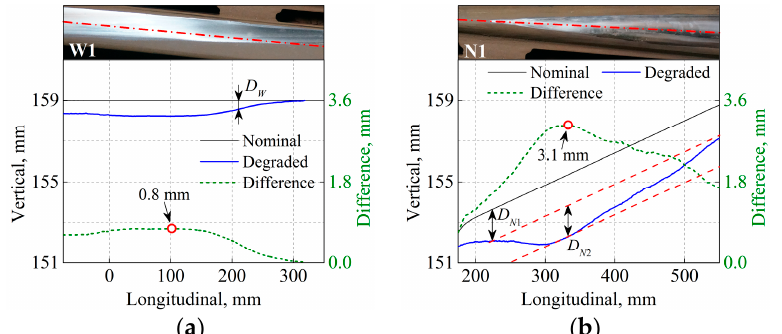
Figure 7. Measured crossing profile along cross sections W1 and N1. ( a ) Wing rail and ( b ) crossing nose. The dot ( ○ ) indicates the maximum difference in height between the nominal and degraded states. D W denotes the difference in the height of the wing rail, while D N 1 and D N 2 denote the difference in the height of the crossing nose.